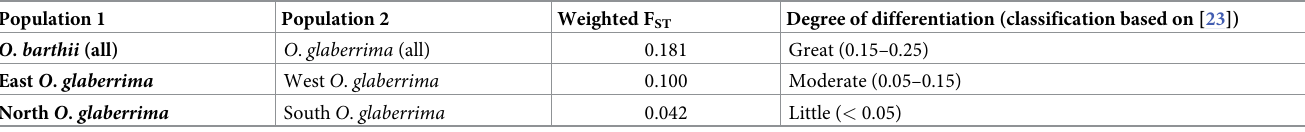
Table 1. Fixation index (F ST ) between species and between geographic clusters.